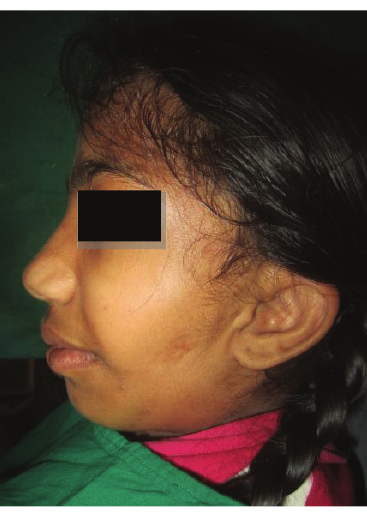
Figure 2: Lateral view.